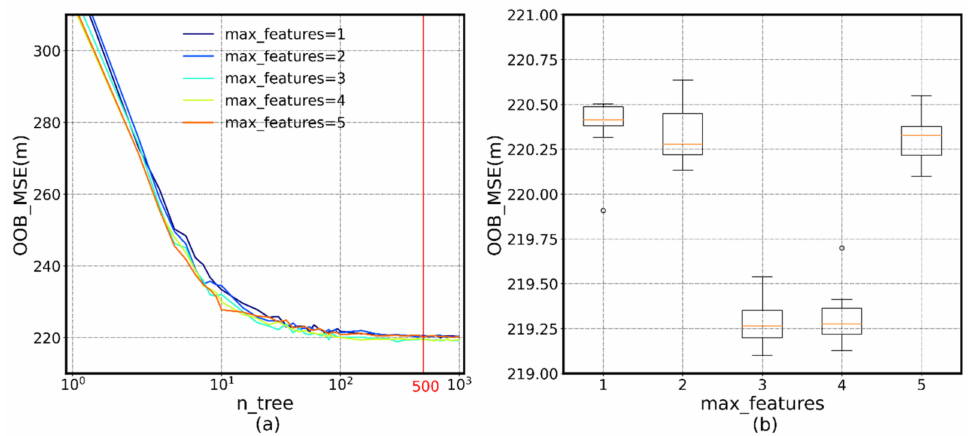
Figure 5. ( a ) OOB_MSE as a function of the number of trees, colors indicate the different value of max_features, and the red line shows where n_tree = 500; ( b ) statistical characteristics of OOB_MSE as a function of max_features when n_tree = 500. The box extends from the lower to upper quartile values of the data with a line at the median, and the whiskers extend from the box to show the range of the data while outliers are shown as flier